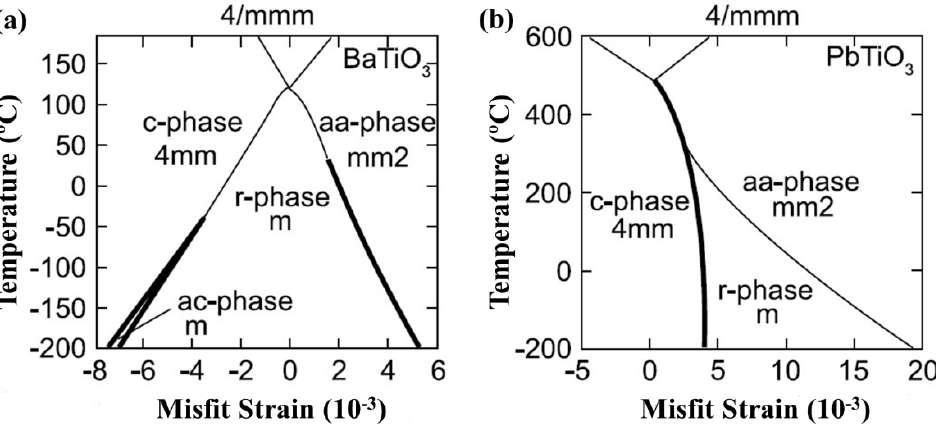
Figure 8. Misfit strain-temperature phase diagrams of (001)-oriented ( a ) BaTiO 3 (Reprinted with permission from [18]; Copyright 1999 by Taylor & Francis) and ( b ) PbTiO 3 (adopted from [17]) thin films calculated by thermodynamic analysis. (Reprinted with permission from [17]; Copyright 1998 by the American Physical